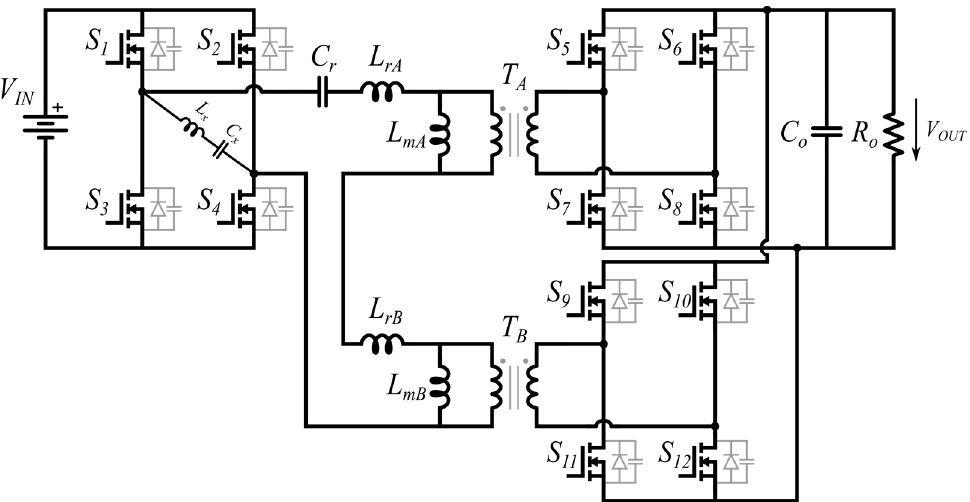
Figure 22. LLC full-bridge with a series parallel transformer configuration and two output-synchronous full-bridges.